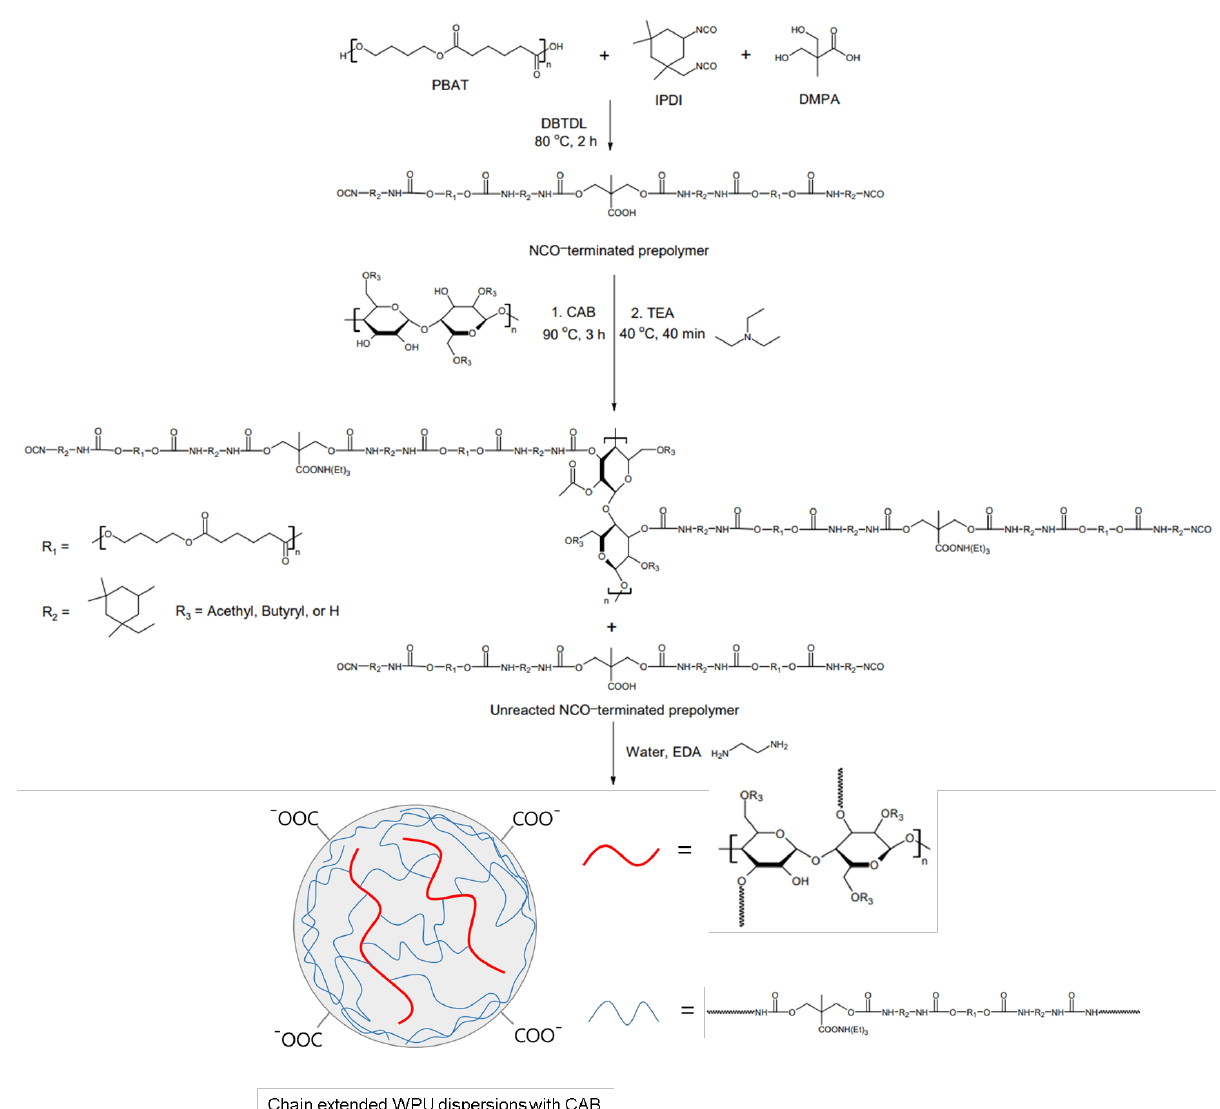
Figure 1. Preparation of chain-extended WPU dispersions with CAB.